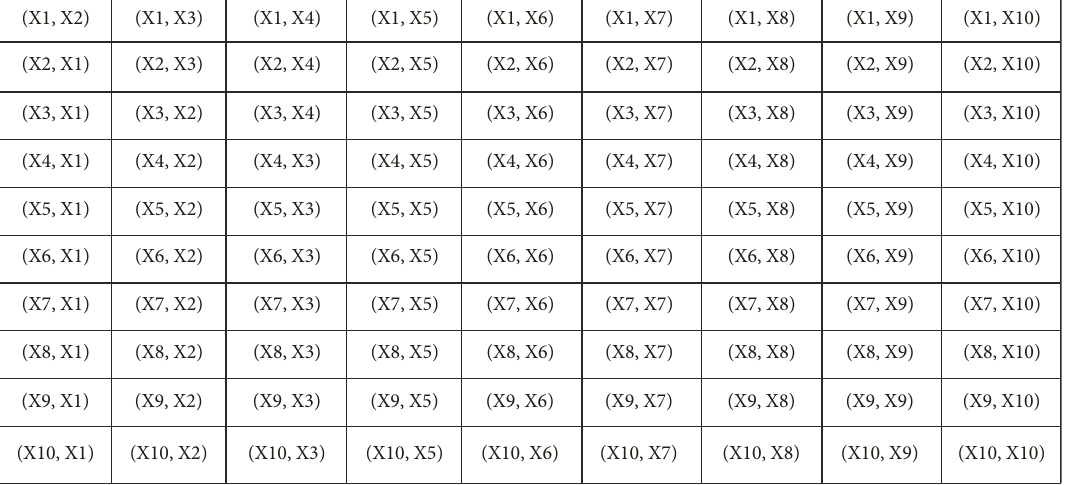
Figure 4: Schematic diagram of the mutual information matrix.